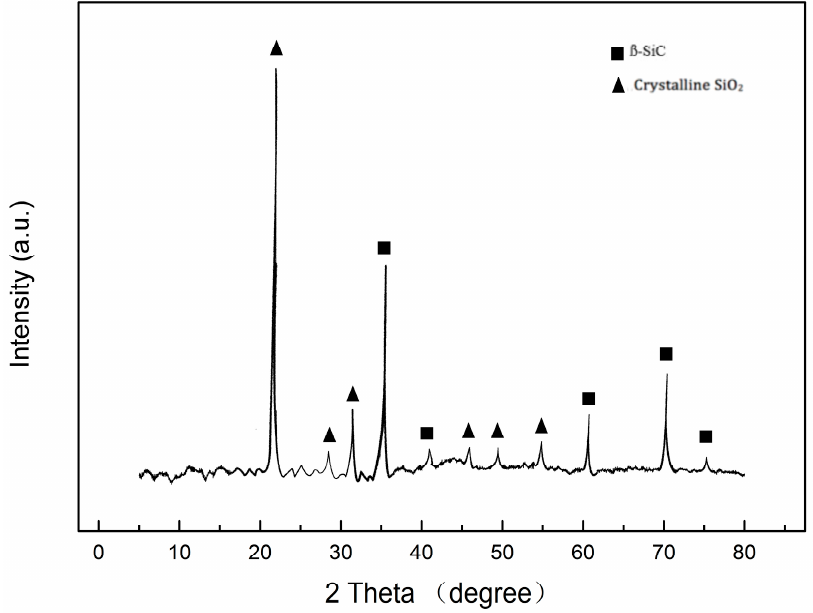
Figure 6. XRD analysis of SiC/SiO 2 coated CF with 1400 °C treated for 15 min.